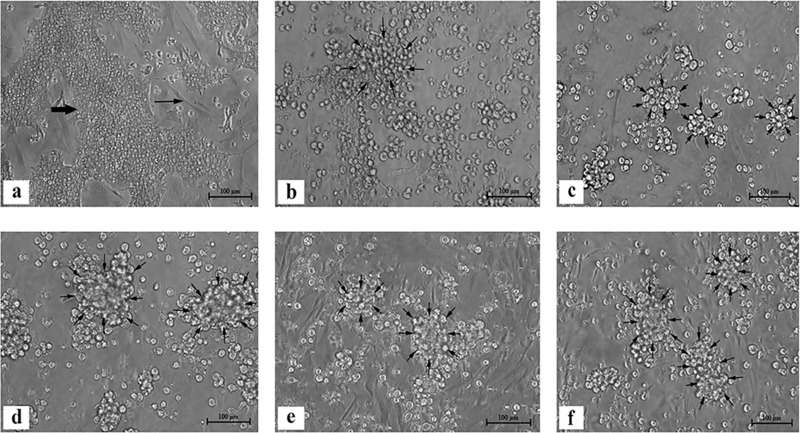
Cytopathic effects of chicken embryo liver (CEL) cells following inoculation with FAdV isolate, UPM1137.(a) Uninfected primary CEL cells with large irregular epithelial islands (thick arrow) surrounded by network of fibroblast (line arrows) after 4 days culture. (b) Passage 2 (CEL2) infected cells with refractile, rounding and clumping of cells (arrows) at 26 hours pi. (c) Passage 10 (CEL10) infected cells with refractile, rounded and clumping of cells (arrows) at 32 hours pi. (d) Passage 20 (CEL20) infected cells with clumping of (arrows) at 52 hours pi. (e) Passage 30 (CEL30) infected cells with clumping of cells at 62 hours pi. (f) Passage 35 (CEL35) infected cells with refractile, rounding and clumping of cells on entire monolayer (arrows) at 70 hours pi, Scale bar = 100μm.